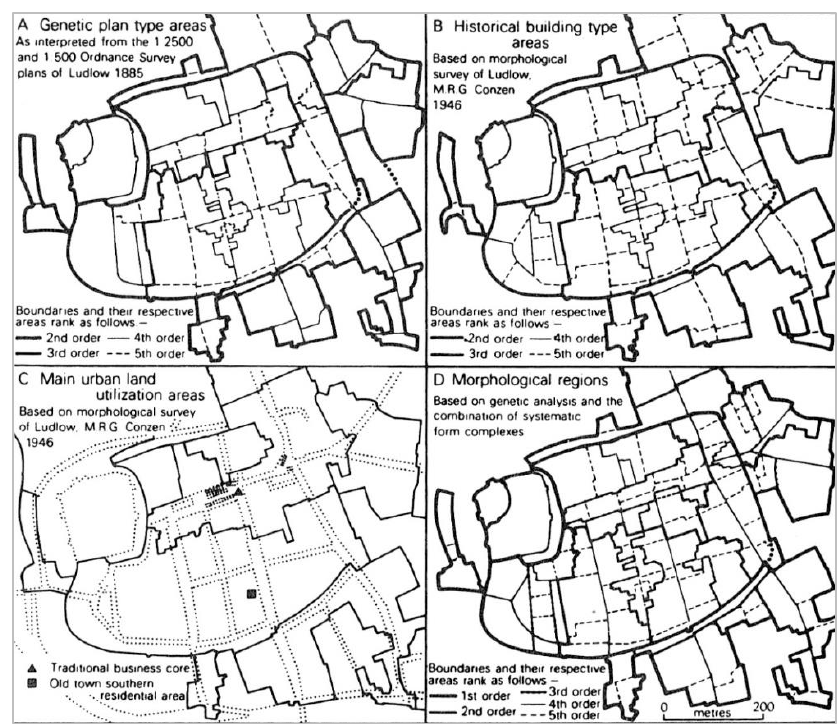
Figure 3 Morphological regions in Ludlow (Conzen,